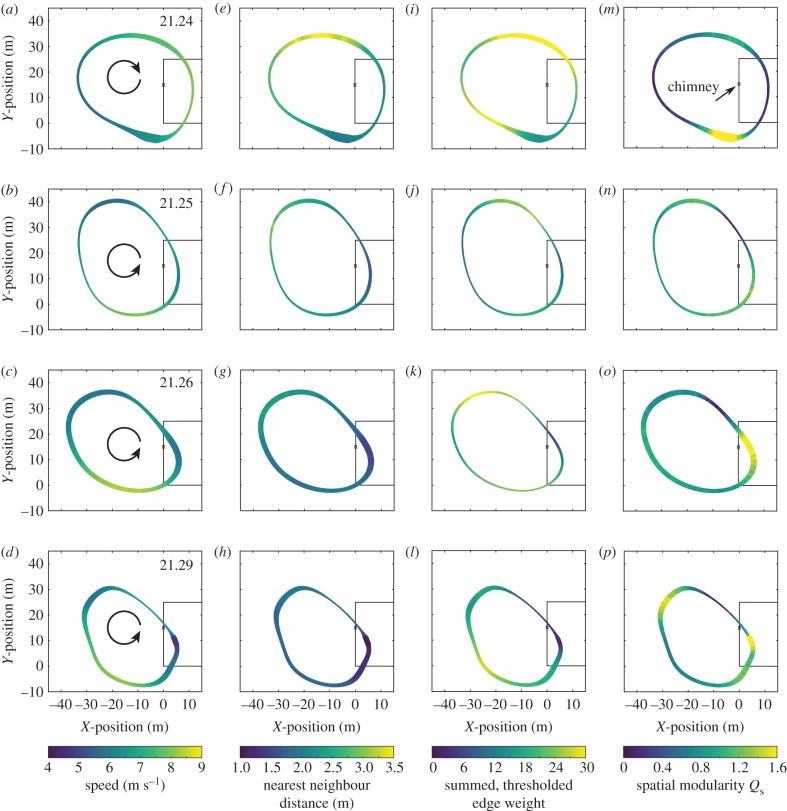
The flock properties change over time and space. Each panel shows the local average per-bird value of a flock property during a time slice, shown along the average flock path for that slice. Time slice varies by row, ranging from flock marshalling (top) to chimney entry (bottom figure 2). Columns 1–4 show, from left to right: speed, nearest neighbour distance, summed thresholded edge weight, and spatial modularity. Flock circling direction is shown in column 1. The chimney building is shown in outline on the right side of the plots and the chimney itself is marked by a small open square. The width of the ribbon indicates the number of observations in each spatial bin.